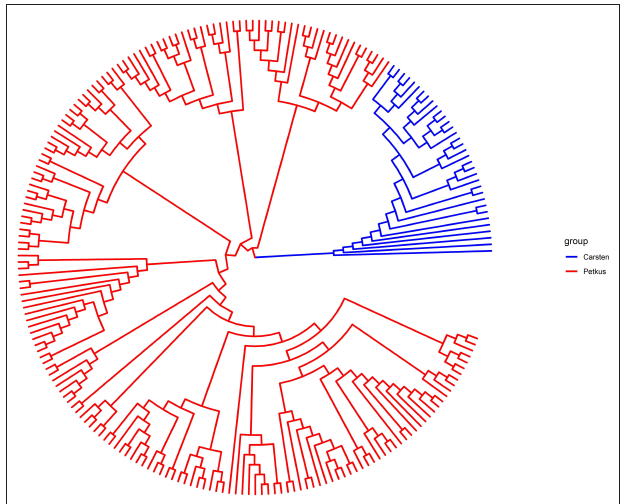
FIGURE 3 | UPGMA-based dendrogram showing the genetic relationship among the 214 elite seed and pollen parent lines based on 2,965 SNP markers. Samples are colored according to the heterotic gene pools ‘Petkus’ (seed parent pool) and ‘Carsten’ (pollen parent pool).